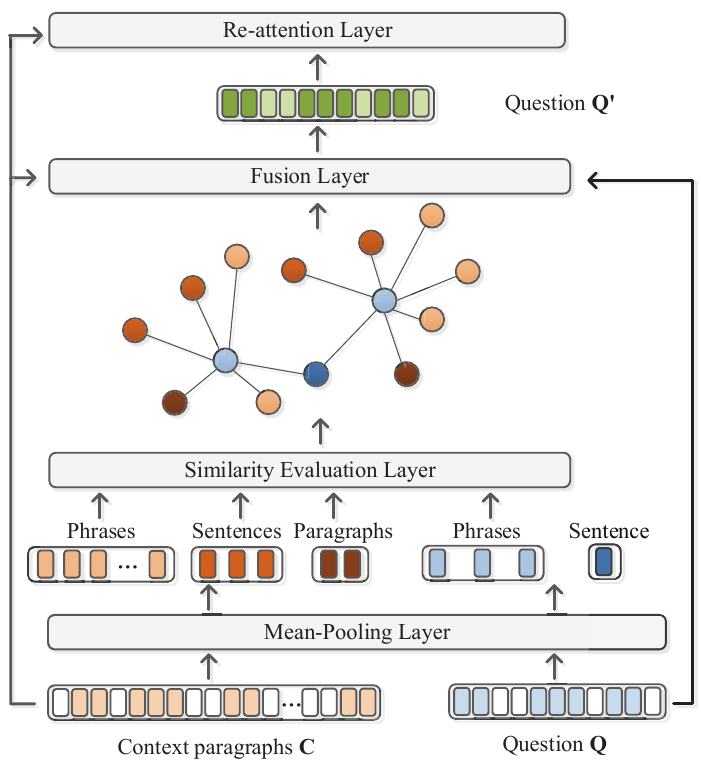
Figure 4. Reasoning process in model